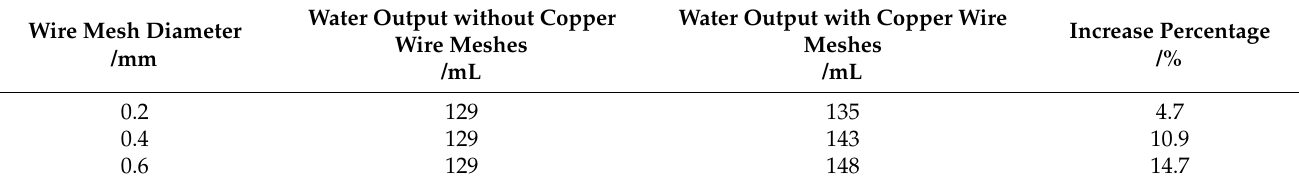
Table 4. Effect of the copper wire mesh diameter on water output.